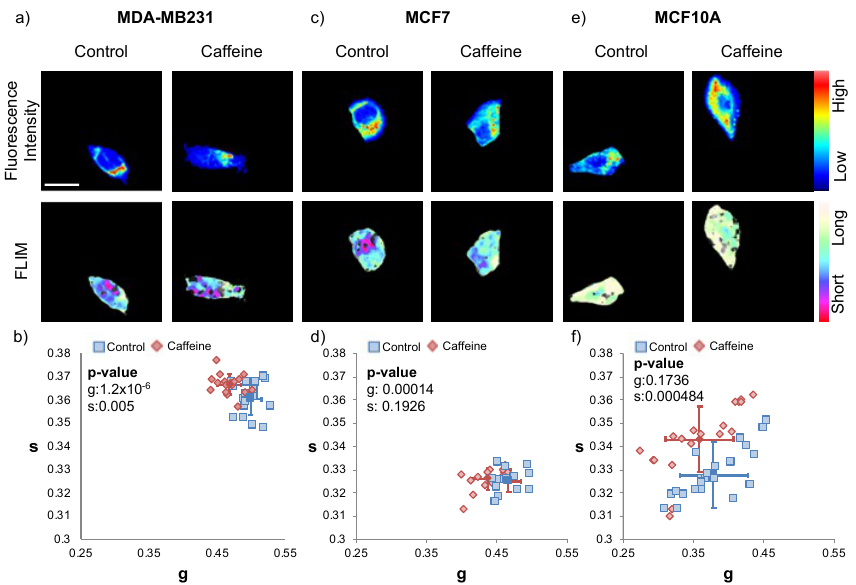
Figure 3. Fluorescence lifetime trajectories of the metabolic state of MDA-MB-231, MCF7, and MCF10A cells with 125 nM ca ff eine for one hour. ( a ) Fluorescence intensity image (top), and FLIM image pseudo colored long lifetime as cyan and short lifetime as red (bottom) for control and ca ff eine treated MDA-MB-231 cells; the scale bar is 20 µ m, and all the images in this figure have the same scale. ( b ) The g and s values of control and ca ff eine treated MDA-MB-231. The blue squares are from the controls (untreated MDA-MB-231), red diamonds are from the ca ff eine treated MDA-MB-231, and the solid shapes (square and diamond) with the error bars correspond to the average and the standard deviation of each group (Student t-test p -values compare the treated group to the control group: g = 1.2 × 10 − 6 , s = 0.005, free to bound NADH ratio = 9.52 × 10 − 7 ). FLIM plot illustrates a leftward shift from short to long lifetimes. ( c ) Fluorescence intensity image (top), and FLIM image pseudo colored long lifetime as cyan and short lifetime as red (bottom) for control and ca ff eine treated MCF7 cells. ( d ) The g and s values of control and ca ff eine treated MCF7. The blue squares are from the controls (untreated MCF7), red diamonds are from the ca ff eine treated MCF7, and the solid shapes (square and diamond) with the error bars correspond to the average and standard deviation of each group (using the Student t-test to compare the treated group to the control group, p -values for g, s and free to bound NADH ratio are 0.00014, 0.1926, 0.0031 respectively). FLIM plot indicates a leftward shift from short to long lifetimes. ( e ) Fluorescence intensity image (top), and FLIM image pseudo colored long lifetime as cyan and short lifetime as red (bottom) for control and ca ff eine treated MCF10A cells. ( f ) The g and s values of control and cisplatin-treated MCF10A. The blue squares are from the controls (untreated MCF10A), red diamonds are from the cisplatin-treated MCF10A, and the solid shapes (square and diamond) with the error bars correspond to the average and standard deviation of each group (using the Student t-test to compare the treated group to the control group, p -values for g, s and free to bound NADH ratio are 0.1736, 0.000484, 0.8028 respectively). FLIM plot illustrates there is no significant shift. This experiment has been scientifically repeated three times. The two other repeats are in Figure